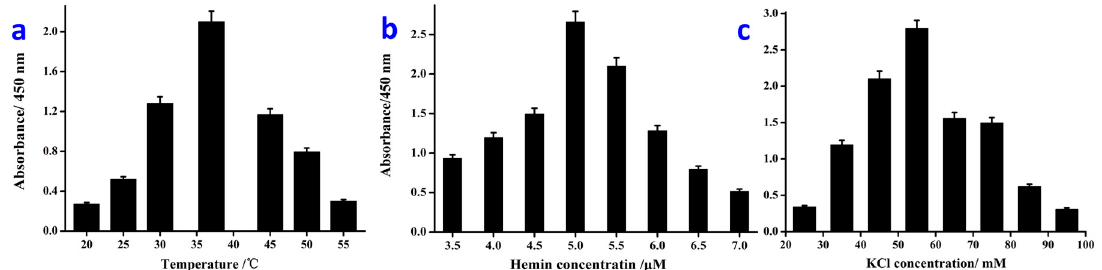
Figure 2. Condition optimization results for rapid colorimetric detection of V. parahaemolyticus . ( a ) Temperature optimization results; ( b ) Optimization of the hemin concentrations; ( c ) Optimization of KCl concentrations for coloration of the catalysis reaction.